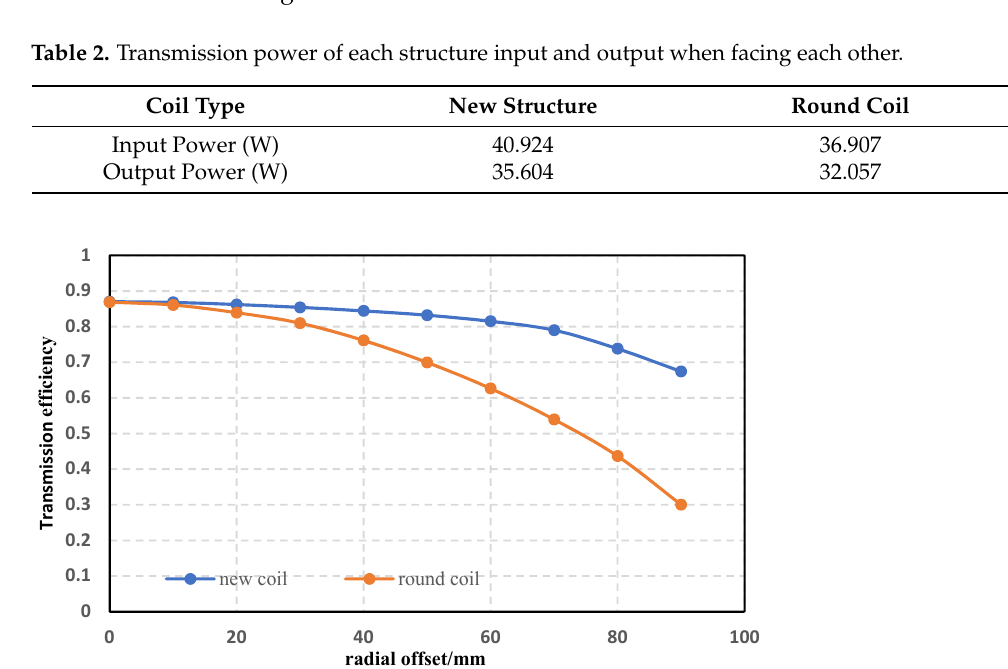
Figure 15. Transmission efficiency and anti-offset capability of the new coil under different loads.